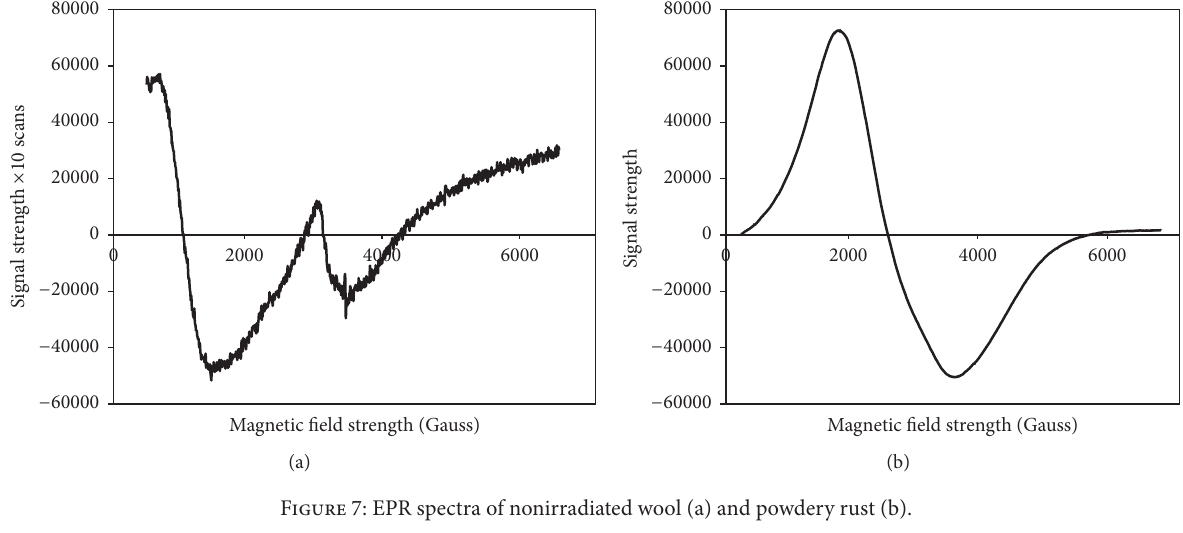
Figure 7: EPR spectra of nonirradiated wool (a) and powdery rust (b).